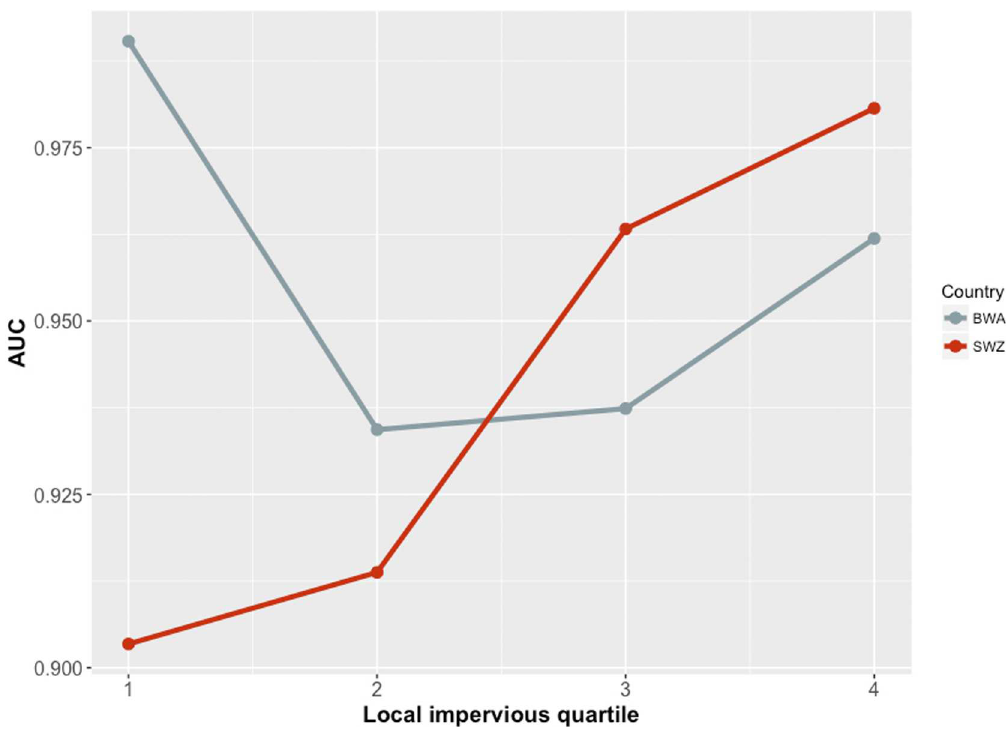
Fig 3. AUC values of the final super learner model by local impervious (urbanicity) quantile for Botswana and Swaziland.